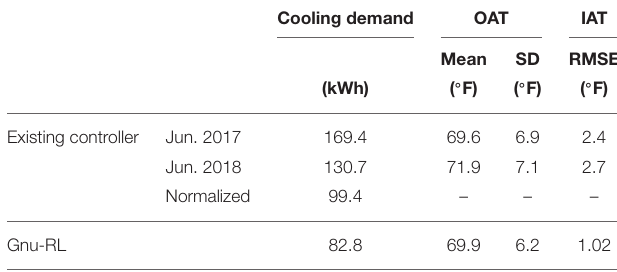
TABLE 5 | Summary of results for real-world